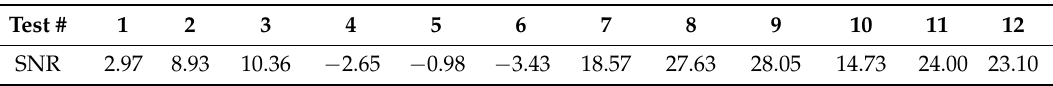
Table 3. Calculated signal-to-noise ratio (SNR) with respect to the coherent noises in the inspection (in dB).